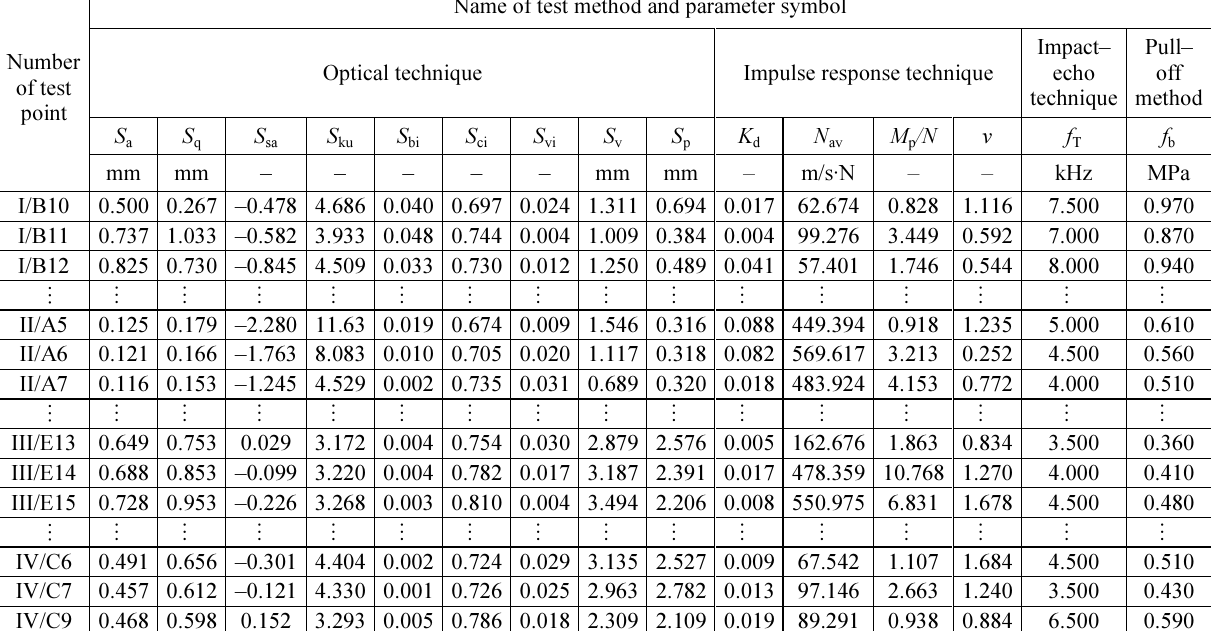
Table 1. Sample parameter values obtained for surfaces from I to IV of model specimens no. 1 and 2